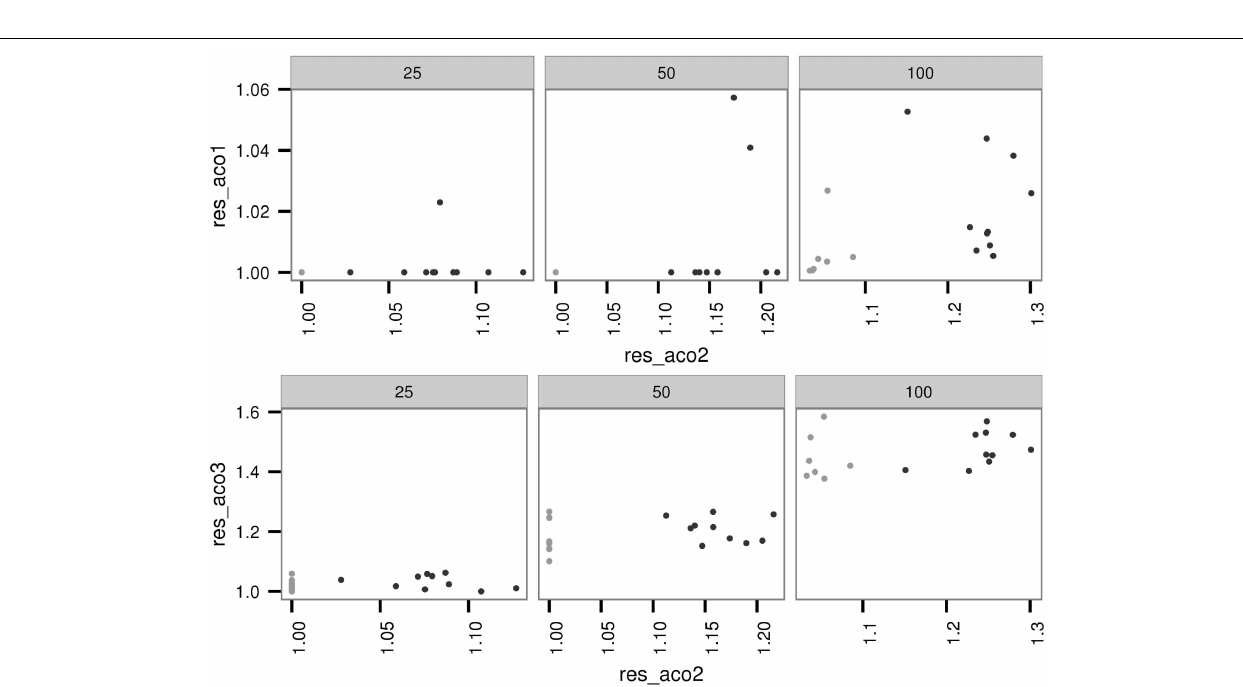
FIGURE 7 | Performance of the first ( res _ aco 1) parameter setting (top) and the third ( res _ aco 3) parameter setting (bottom) on the easy (gray) and hard (black) instances of the second( res _ aco 2) parameter setting .